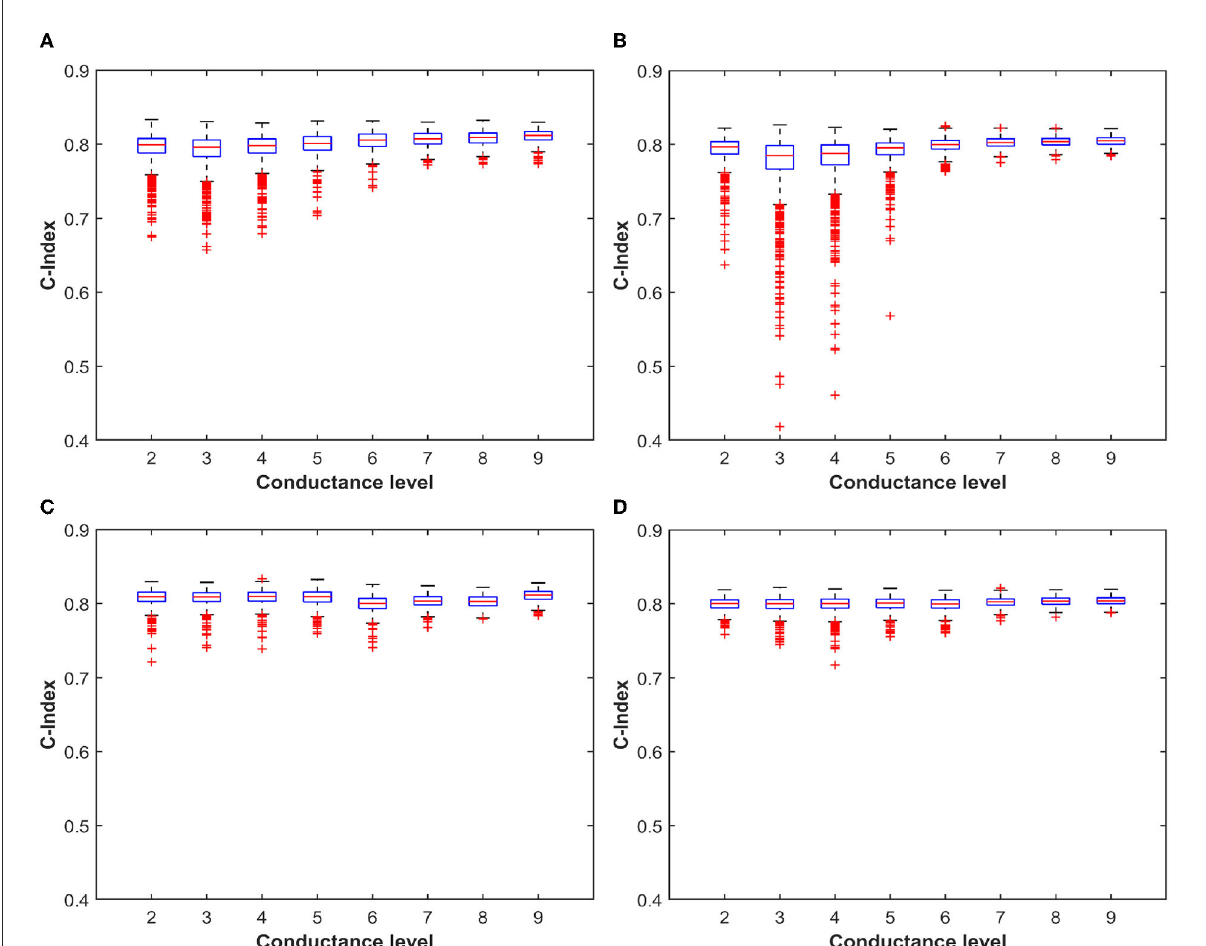
FIGURE10 (A) Boxplot of the C-Index value over 1,000 simulation with the distribution obtained from ML-Set at the end of the programming algorithm. (B) Boxplot of the C-Index value over 1,000 simulation with the distribution obtained from ML-Set after 168 h evidencing the effect of the drift. (C,D) The same analysis performed for